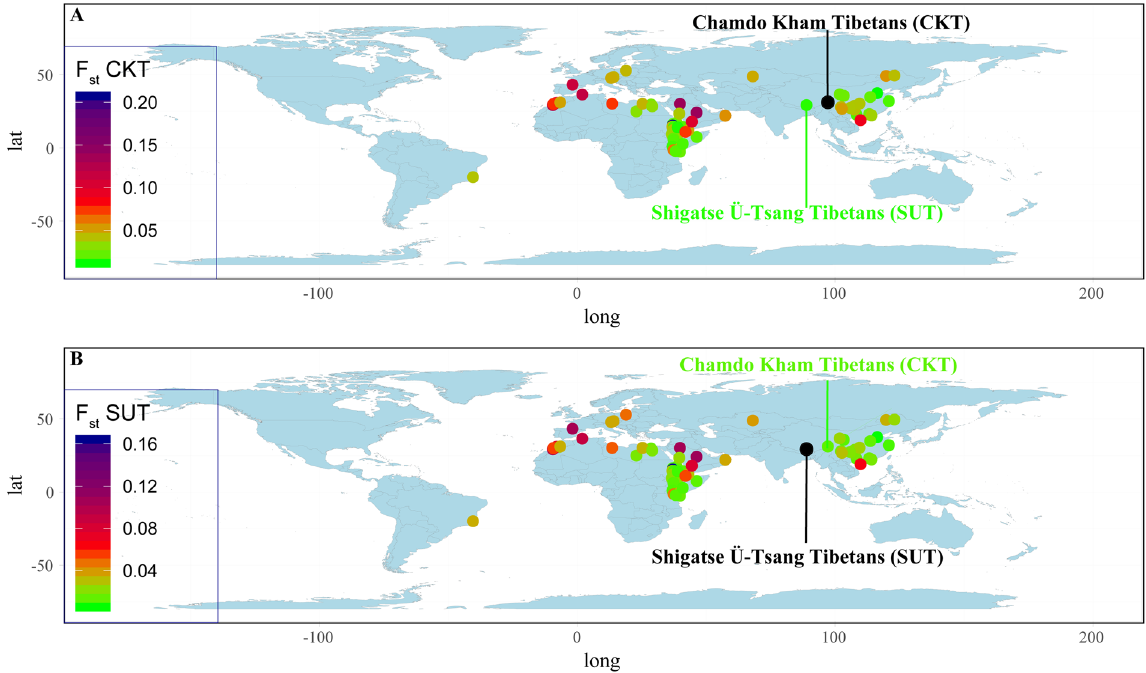
Figure 3. Heatmaps show the pairwise genetic distances between Tibetans and the other 61 reference